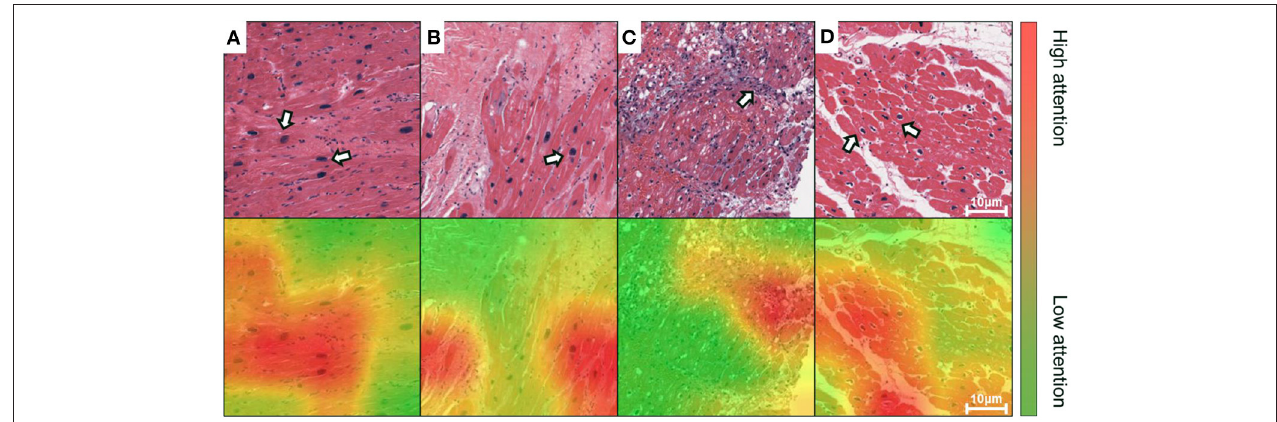
FIGURE 4 | Grad-CAM generates attention maps to visualize the dominant morphology on endomyocardial biopsy (EMB) images. The attention maps are visualized as overlaid heatmaps on top of the H&E stained histopathological images. All suspected injured regions, including (A,B) enlarged nuclei, (C) inflammatory infiltration, and (D) perinuclear vacuolation, are indicated by arrows in the top panel or labeled as high attention in red in the bottom, whereas the other regions with low attention are in green. Scale bars: 10 µ m.